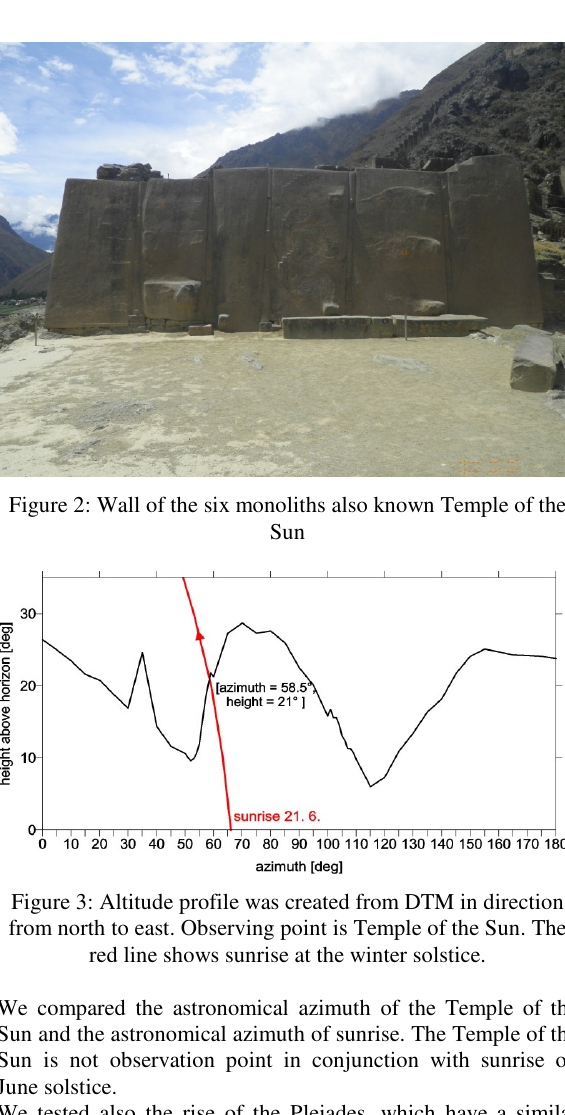
2. OLLANTAYTAMBO